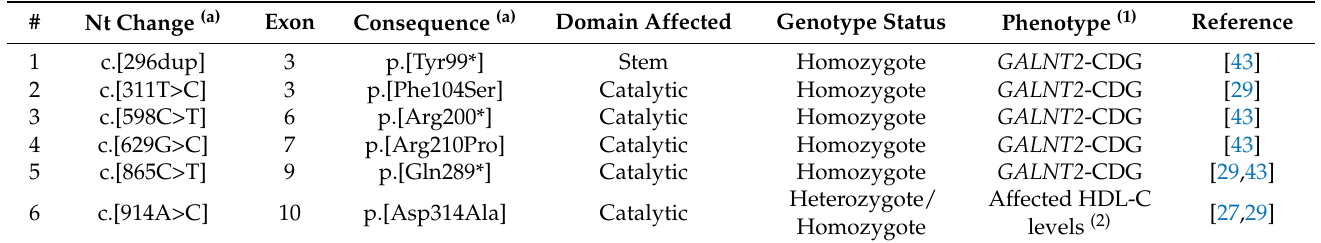
Table 1. Summary of published GALNT2 mutations and associated